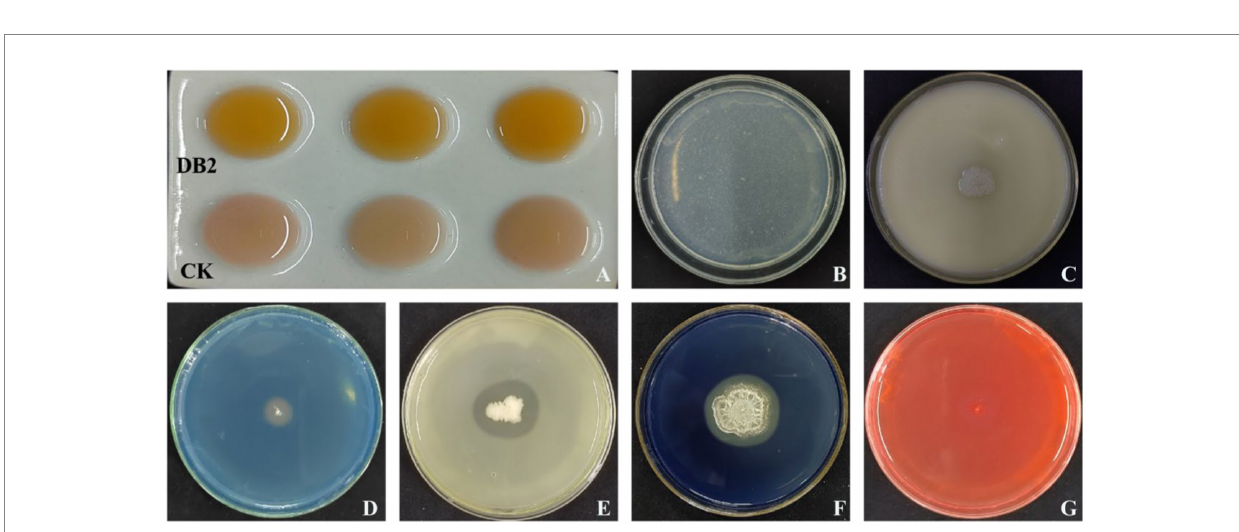
FIGURE 7 PGP and antifungal traits of strain DB2. (A) The upper indicating IAA production by color change. (B) The strain DB2 was negative on the inorganic phosphate solubilization test by no halo zone around colonies. (C) The strain DB2 was negative on the organic phosphate solubilization test by no halo zone around colonies. (D) Yellow-orange halos indicating siderophore production. (E) Protease activity indicated by a clear zone around strain DB2 colonies. (F) Amylase activity indicated by an obvious hydrolytic zone around strain DB2 colonies. (G) The strain was negative for cellulase activity by no zone of hydrolysis around strain